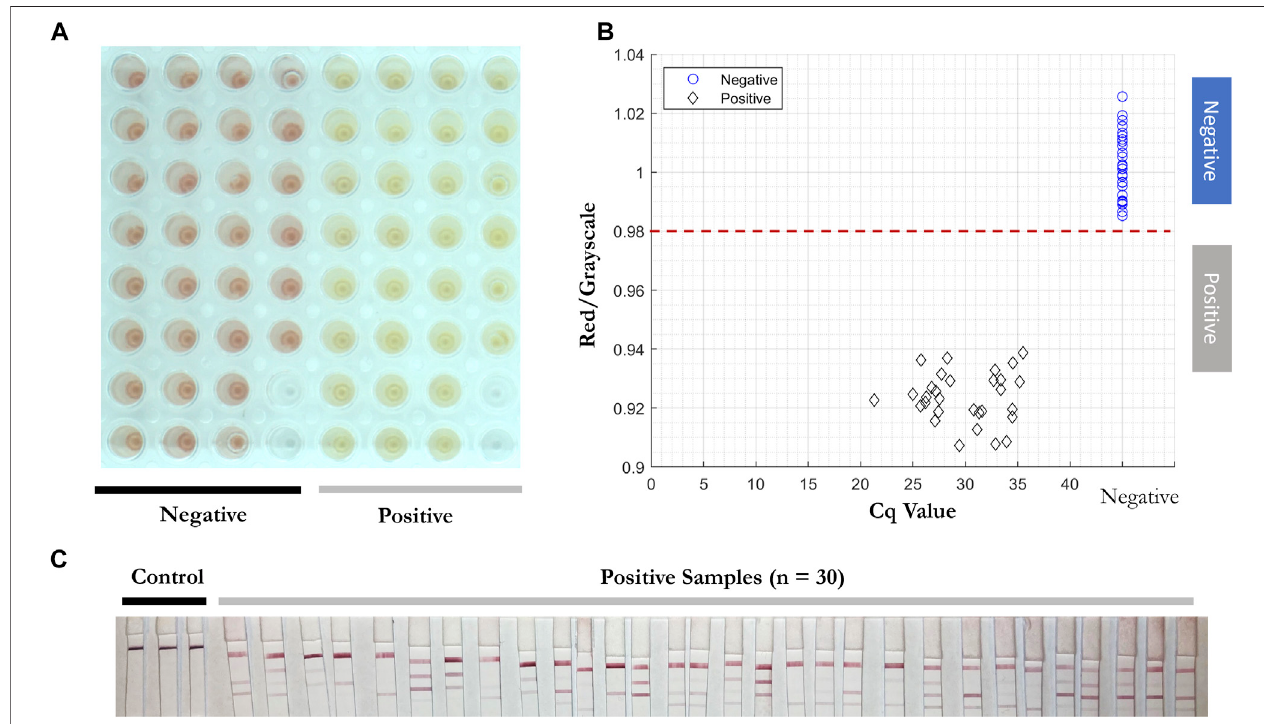
FIGURE9| DirectRT-LAMP-LFIAtestingof30positiveand30negativeclinicalnasopharyngealswabspecimenswithoutapriorRNApuri fi cationorextraction. (A) RT-LAMPproductsfor30positiveand30negativeclinicalsamplesampli fi edwiththree setsofprimers,takenbyoverviewcamera. (B) Red/grayscalevs.copy numbers of both positive and negative samples. (C) LFIA read-outs for RT-LAMP products ampli fi ed for all three genes.